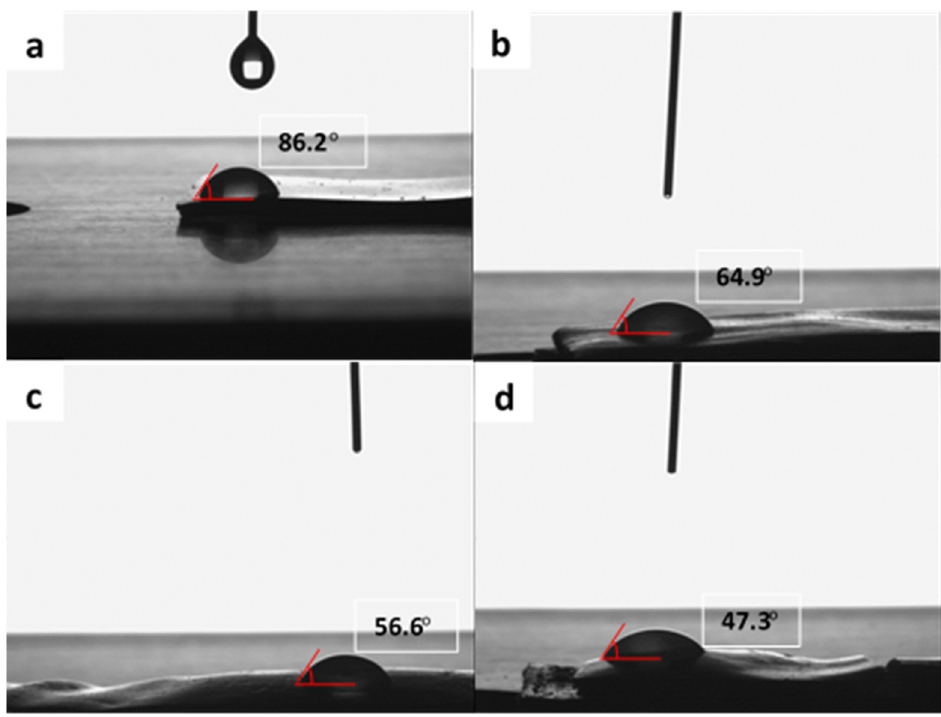
Figure 5. Contact angle micrographs of ( a ) CA, ( b ) CTG—100, ( c ) CTG—300 and ( d ) CTG—500 membranes recorded after every 20 s.